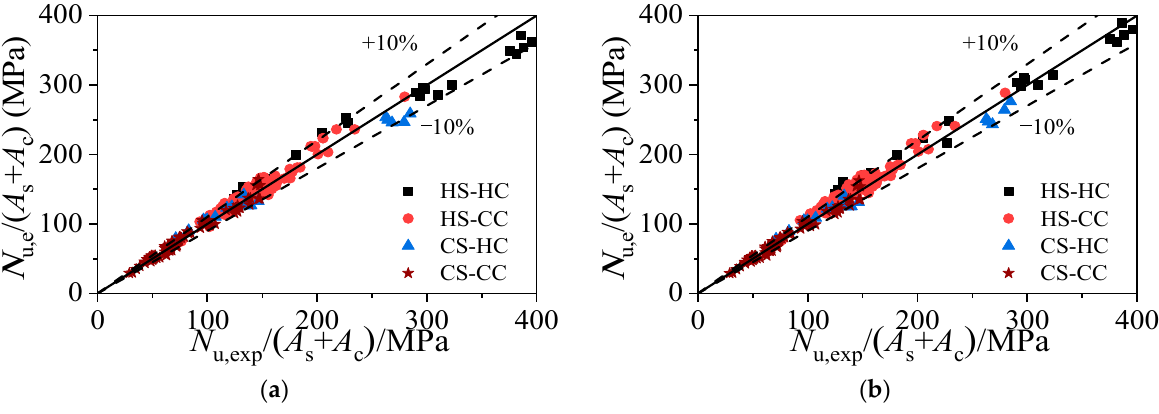
Figure 13. Comparison of experimental results with Equation (16) and FE, respectively. ( a ) Comparison of average ultimate stress from test and Equation (16). ( b ) Comparison of average ultimate stress from test and FE.